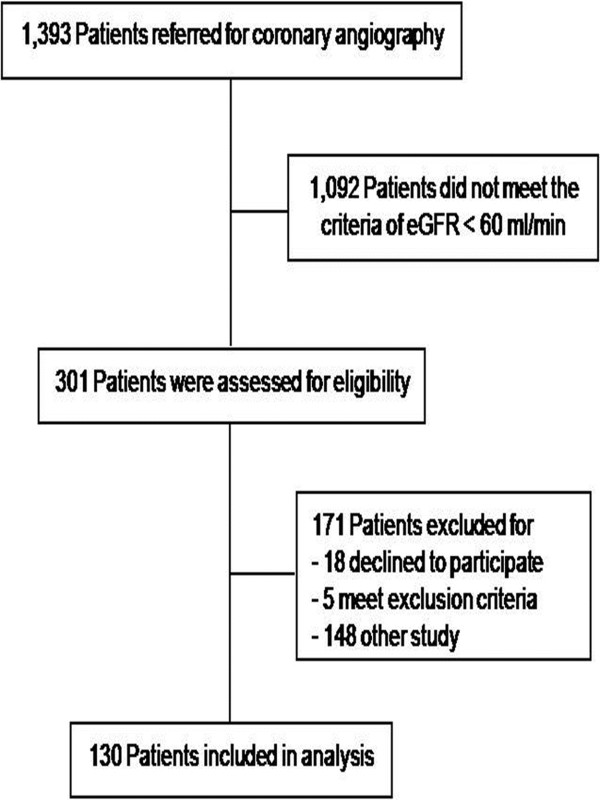
Diagram showing the flow of patients through each step of trial.